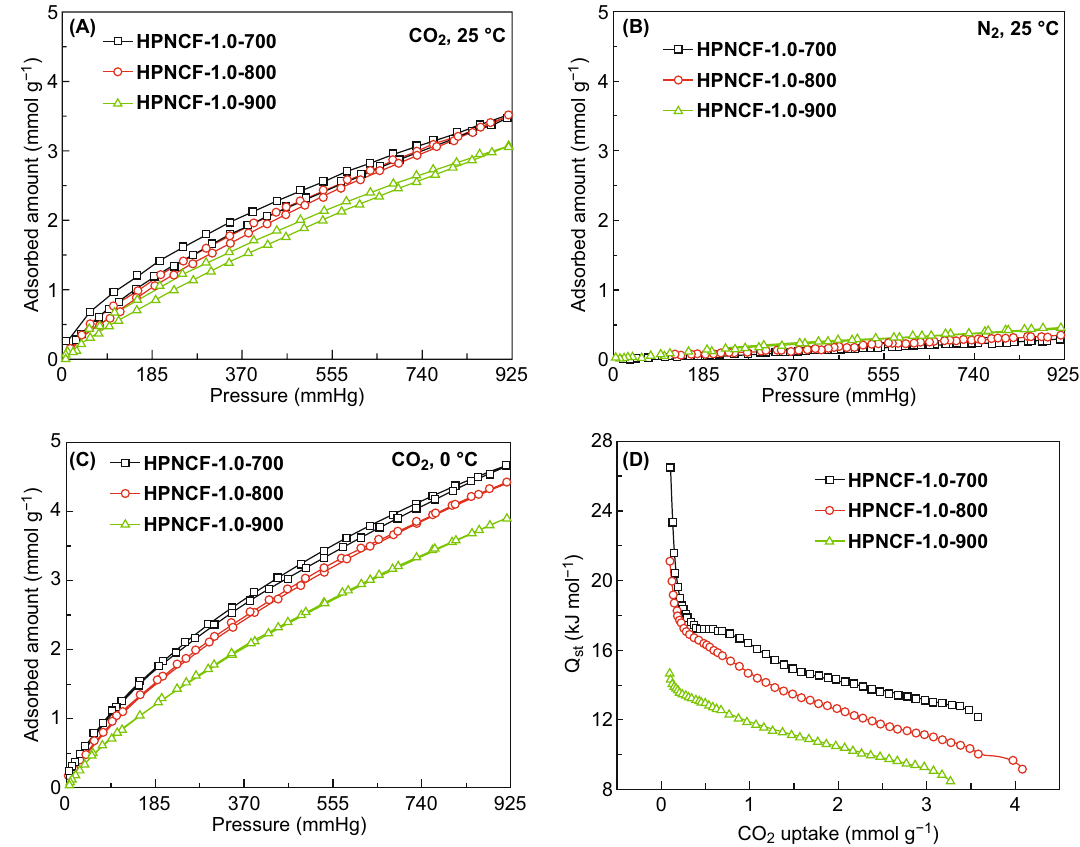
Fig. 7 CO 2 ( A , C ) and N 2 ( B ) sorption isotherms at 25 ( A , B ) and 0 °C ( C ), and the corresponding isosteric heat of adsorption curves ( D ) of HPNCF-1.0-700, HPNCF-1.0-800, and